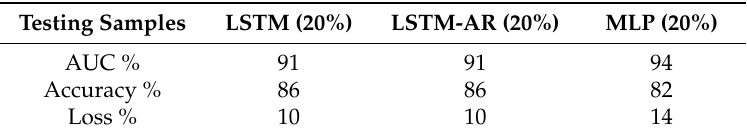
Table 8. LSTM, LSTM-AR, and MLP models: AUC, accuracy and loss results by considering the dataset found in reference